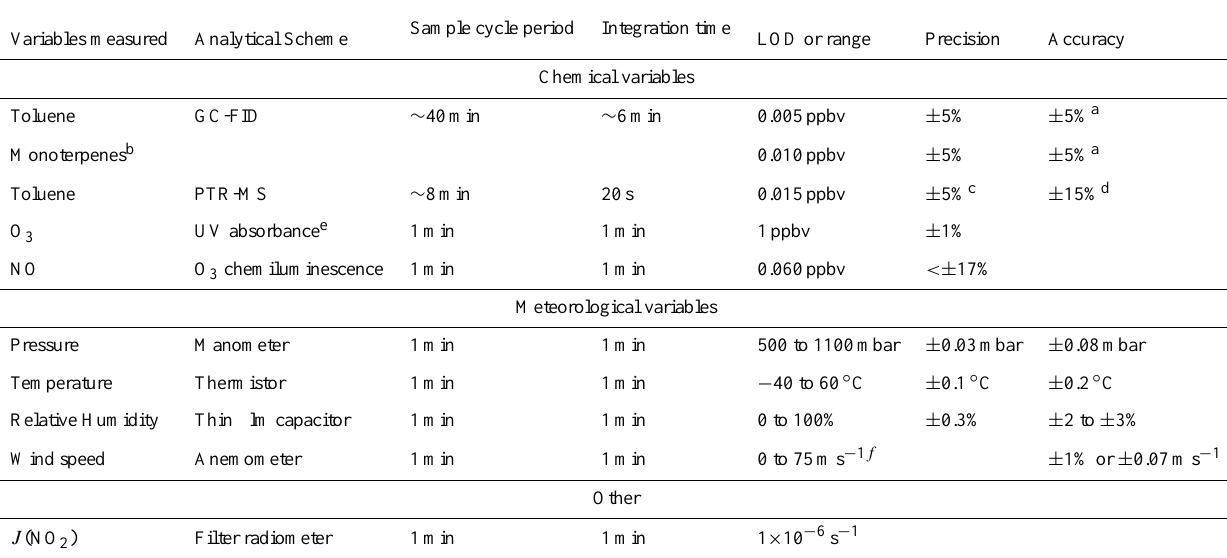
a For standard mixing ratio. b Quality parameters derived from analysis of n -decane standard. c For calibration factor ( C measurement precision was estimated from counting statistics as described previously (Hayward et al., 2002; de Gouw et al., 2003a) and was